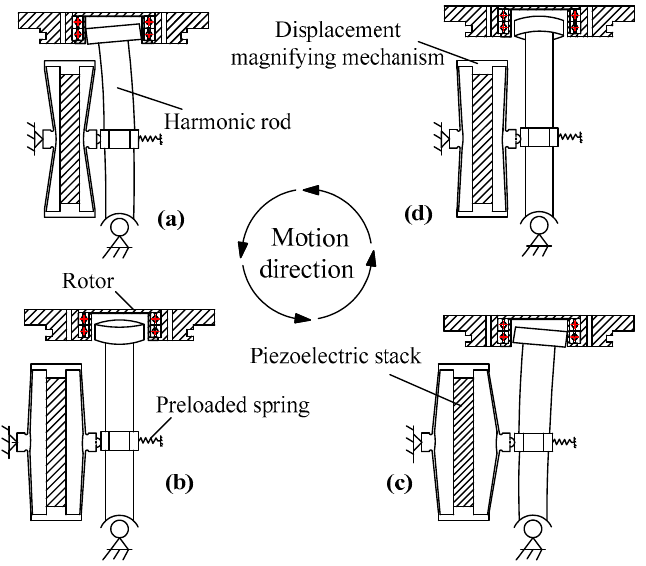
Figure 1. Working principle of the low-frequency harmonic rotating piezoelectric actuator. ( a ) The position of 0 degrees or 360 degrees; ( b ) The positions of 90 degrees; ( c ) The positions of 180 degrees; ( d ) The positions of 270 degrees.